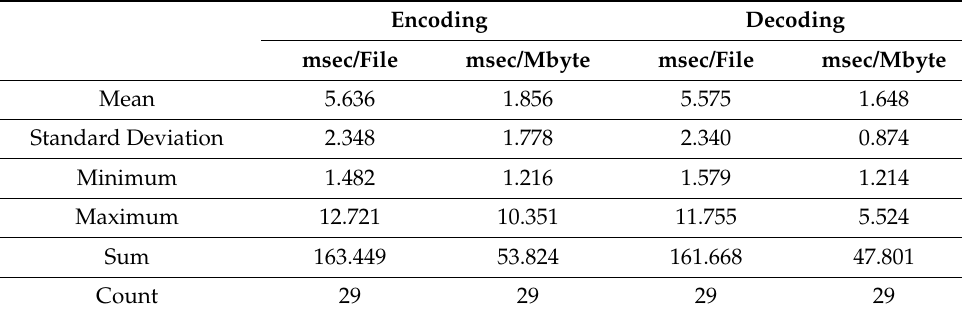
Table 10. Encoding & Decoding Time Descript Statistic